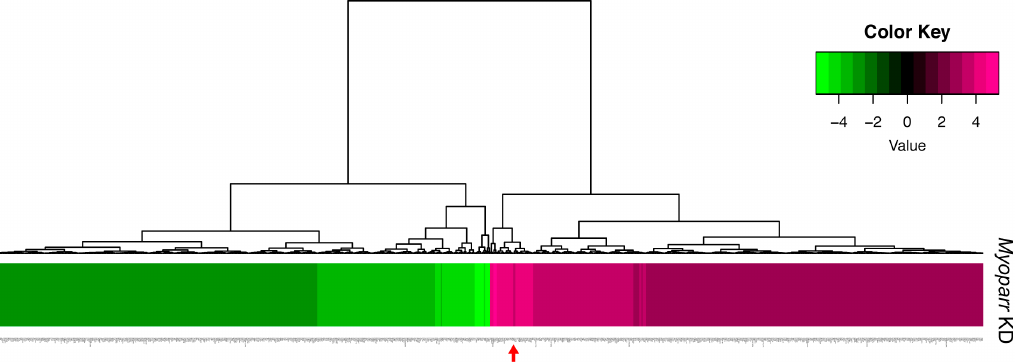
Figure 2. Knockdown of Myoparr altered global gene expressions in denervated skeletal muscle. The heatmap displayed the changes in expression for 848 genes altered by Myoparr knockdown in denervated TA muscle of C57BL/6J mice (values are z-scores). The black and red arrow indicate the decreased expression of myogenin and increased expression of Gdf5 , respectively.